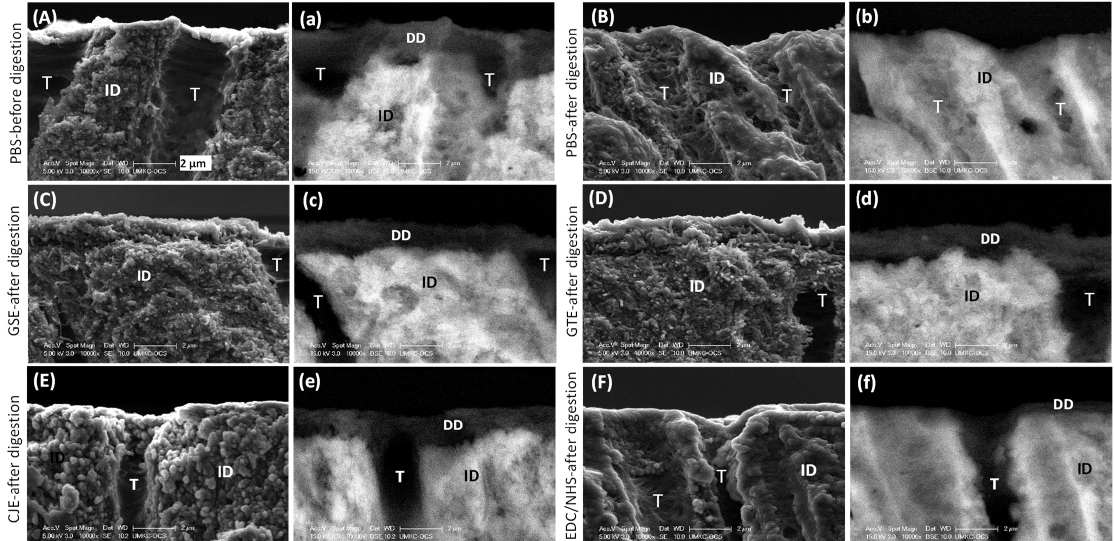
Figure 3. Representative SEM images of the untreated PBS control and cross-linker-treated demineralized dentin layers before and after 1 h of digestion in 0.1% collagenase in the secondary electron mode ( A – F ) and the backscattered electron mode ( a – f ). ( A , a ) PBS control before digestion. ( B , b ) PBS control after digestion. ( C , c ) GSE-treated group after digestion. ( D , d ) GTE-treated group after digestion. ( E , e ) CJE-treated group after digestion. ( F , f ) EDC/NHS-treated group after digestion. PBS: phosphate buffered saline. GSE: grape seed extract. GTE: green tea extract. CJE: cranberry juice extract. EDC/NHS: carbodiimide/n-hydroxysuccinimide. DD: demineralized dentin. ID: intact dentin. T: tubule.